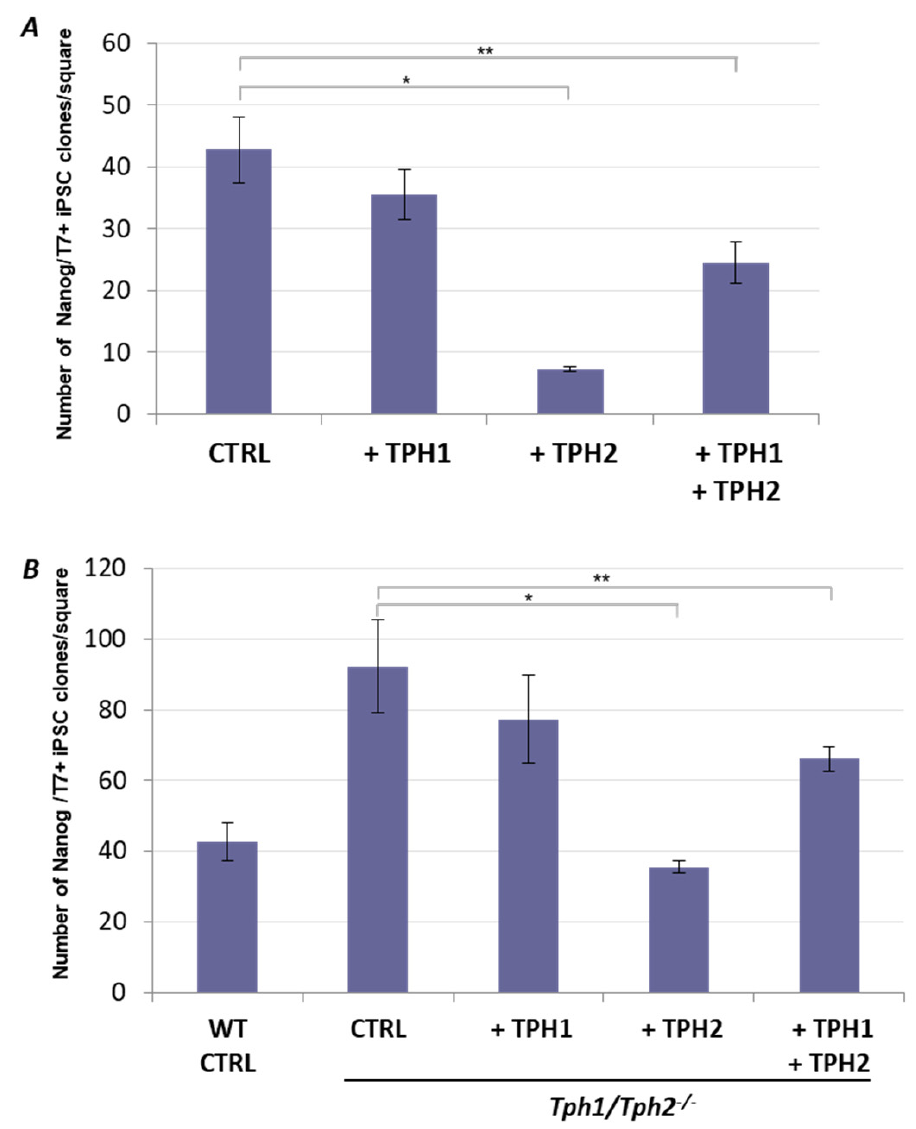
Figure 2. TPH2 suppresses cell reprogramming to pluripotent state. ( A ) Ectopic expression of TPH1 and TPH2 during reprogramming of WT MEFs. iPSC clones were revealed by co-immunostaining for Nanog and T7 epitope which tagged the exogenous TPH proteins. Ectopic expression of TPH2 alone or in conjuncture with TPH1 significantly suppresses efficiency of iPSC generation by OKSM lentiviruses. ( B ) Ectopic expression of TPH2 during reprogramming of Tph1/Tph2 − / − MEFs completely reverted its efficiency to the WT level, while its co-expression with TPH1 had a lesser effect. Overexpression of TPH1 alone did not significantly affect the reprogramming efficiency of Tph1/Tph2 − / − MEFs. Equal numbers of the TPH-encoding lentiviruses were supplemented during the reprogramming (A and B), and if one or both of them were omitted, the total lentivirus amounts were adjusted with the T7 tag-encoding mock lentivirus (CTRL). Y -axes represent counts of the double-positive iPSC clones ± SD; n = 4 (technical replicates); * p < 0.0005, ** p < 0.005 (Student’s t - test).